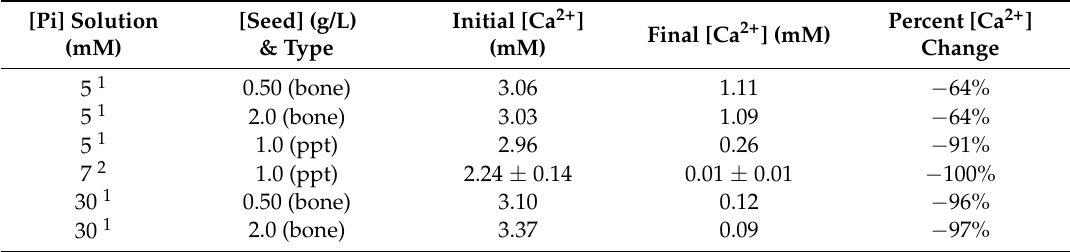
Table 5. Summary of [Ca 2+ ] results for the batch, seeded precipitation tests.